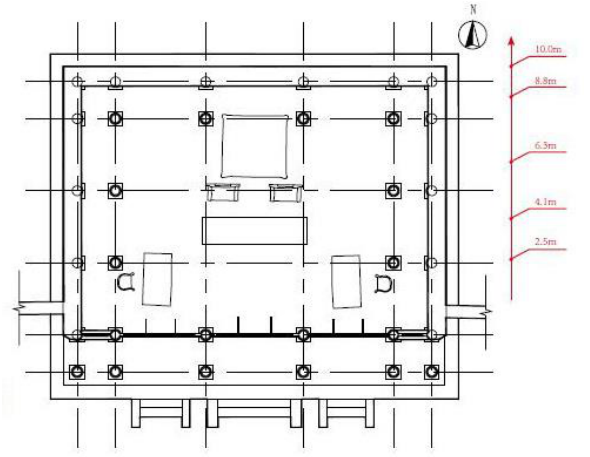
Figure 9 stress wave probes in